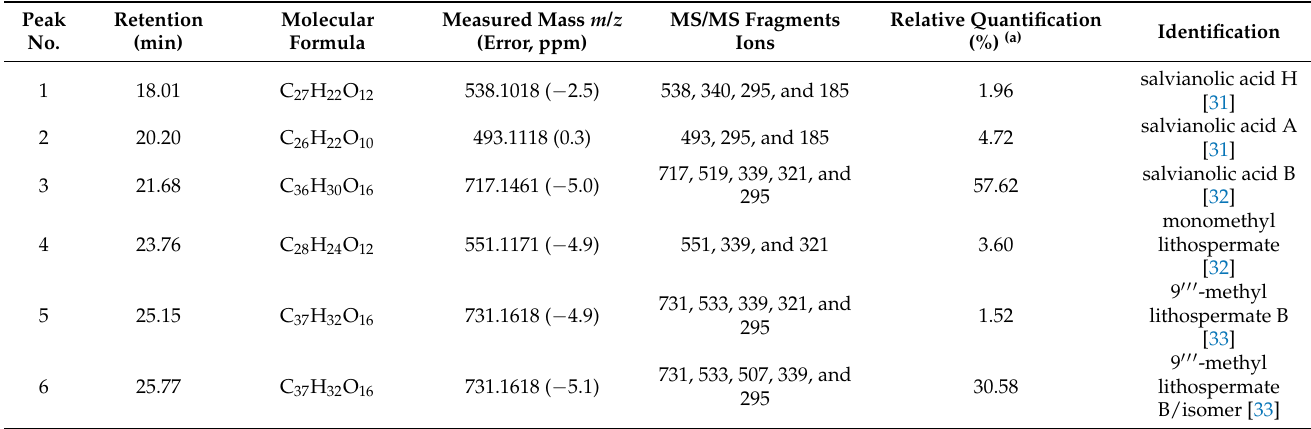
Figure 2. HPLC chromatogram of the SME. Table 1. HPLC–MS identified in the typical base peak chromatogram of the SME samples.